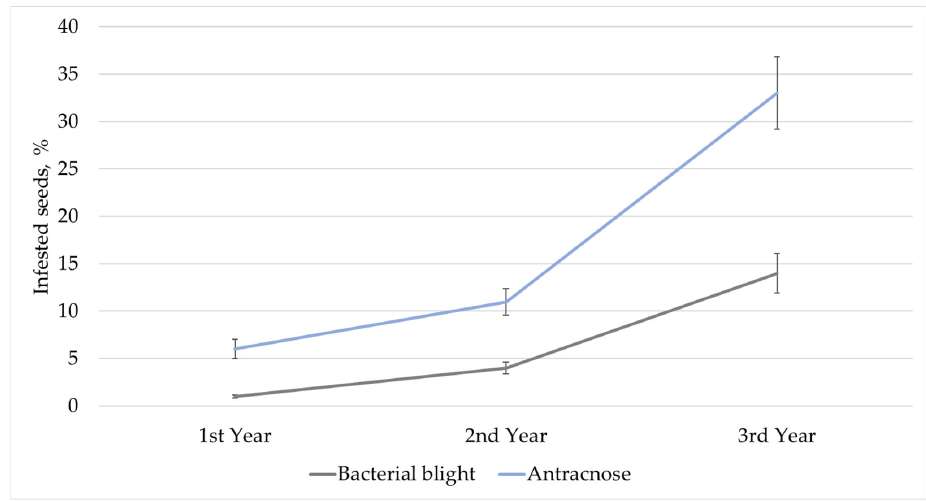
Figure 2. Dynamic of bacterial blight and anthracnose infection in bean seeds.